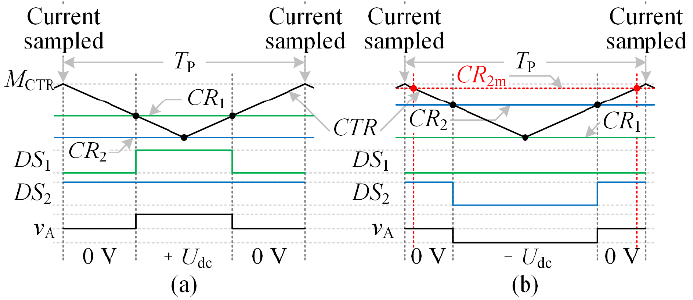
Figure 10. PWM configuration and current sampling timing. ( a ) Positive average phase voltage. ( b ) Negative average phase voltage.